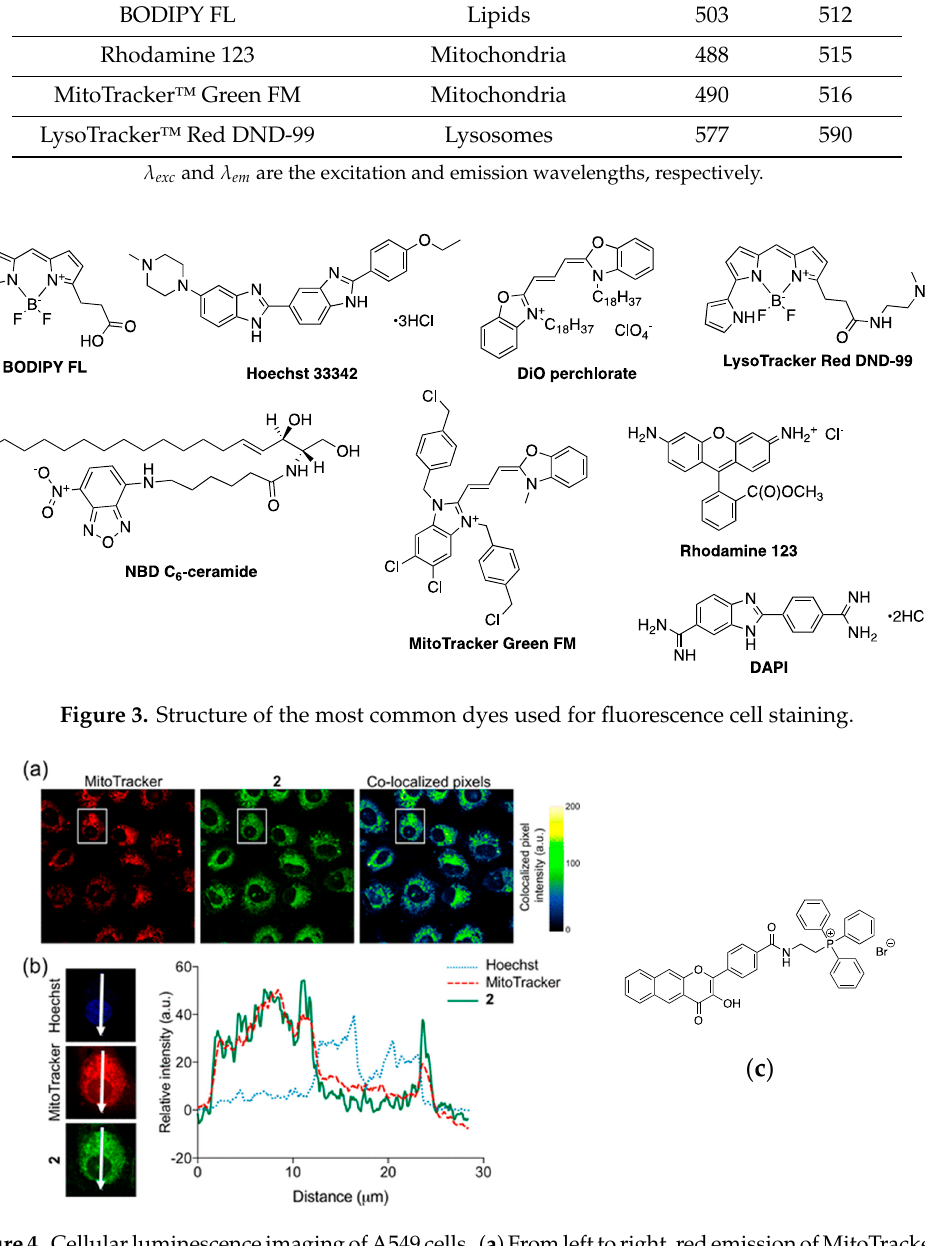
Figure 4. Cellular luminescence imaging of A549 cells. ( a ) From left to right, red emission of MitoTracker™ Red, green emission of the compound photoCORM ‐ 2, and overlay between the red and green channels. ( b ) The emission intensity of the blue, green, and red emissions as a function of the distance across the cell. ( c ) Structure of compound 2. The nucleus and mitochondria were stained with Hoechst 33342 and MitoTracker™ Red, respectively. [Hoechst 33342] = [MitoTracker™ Red] = 300 nM, [2] = 25–100 μ M. Reproduced from [104] with permission from the American Chemical Society. Another problem that arises, especially in the blue and green regions of the electromagnetic where the emission intensity from cells and tissues is high, is a strong background emission that will not allow the detection from the luminescent compound, especially when the compound has low